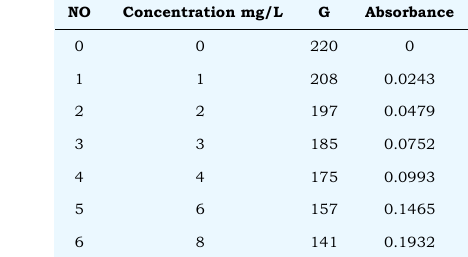
Table 2 The results of the calibration curve for RGB method